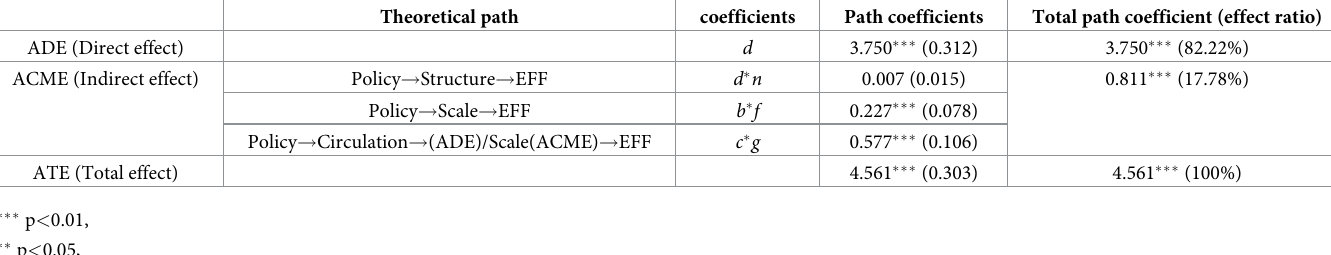
Table 6. Grassland ecological protection subsidy policy affects the results of path analysis of herder breeding technology